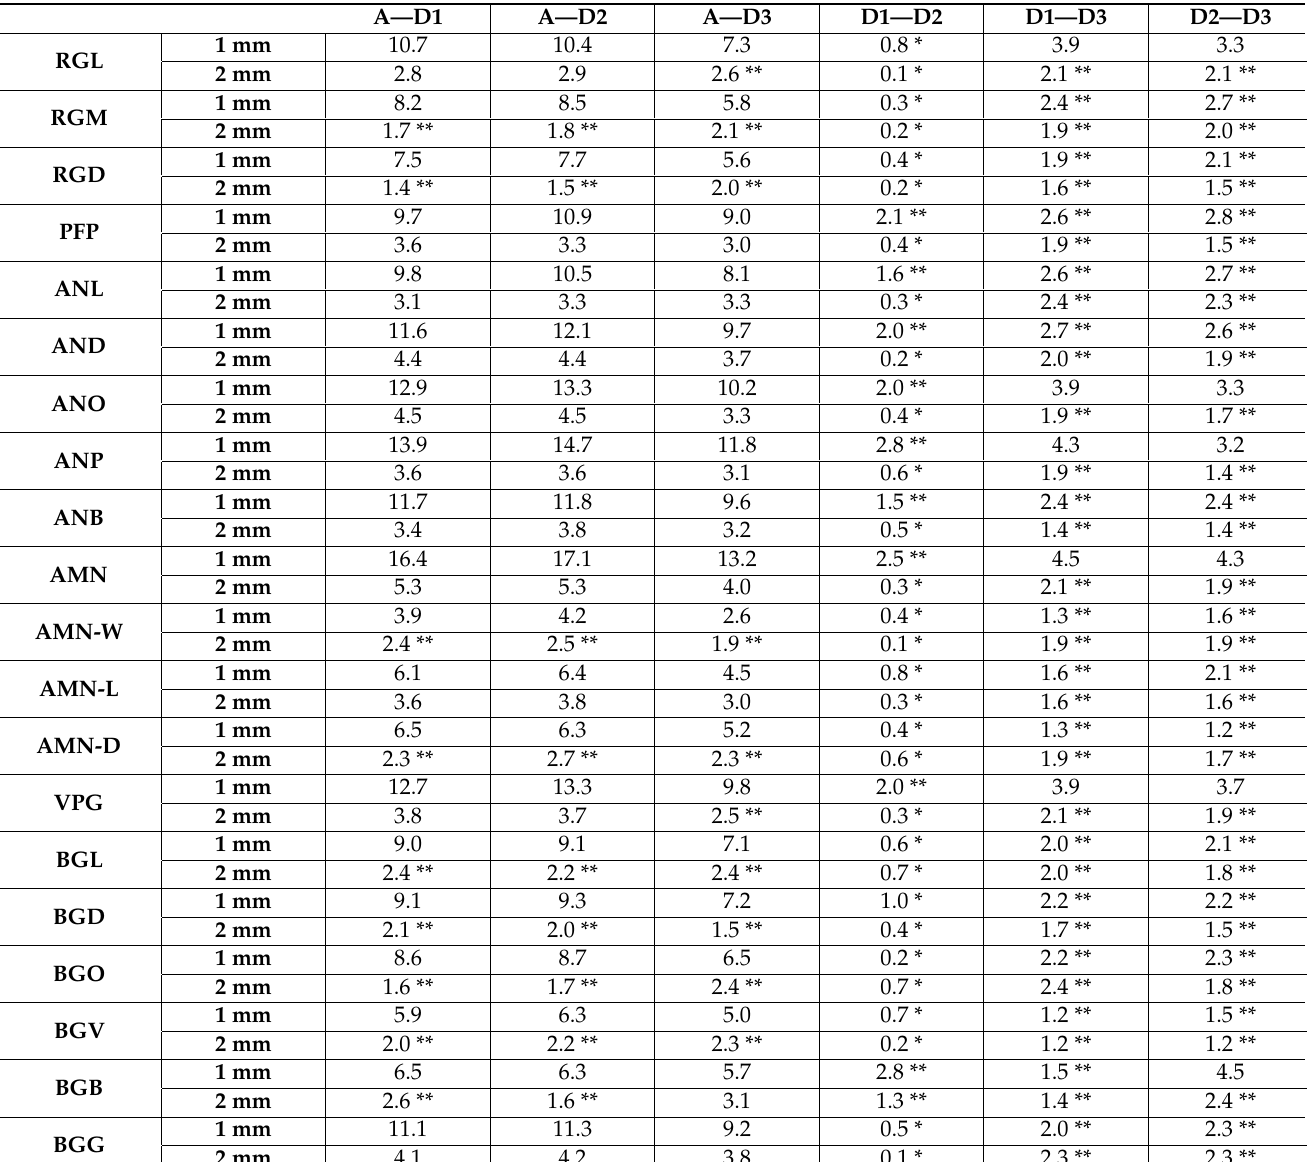
Table 2. Mean CIEDE2000 color difference values for each GCRBC and each thickness of all back- ground